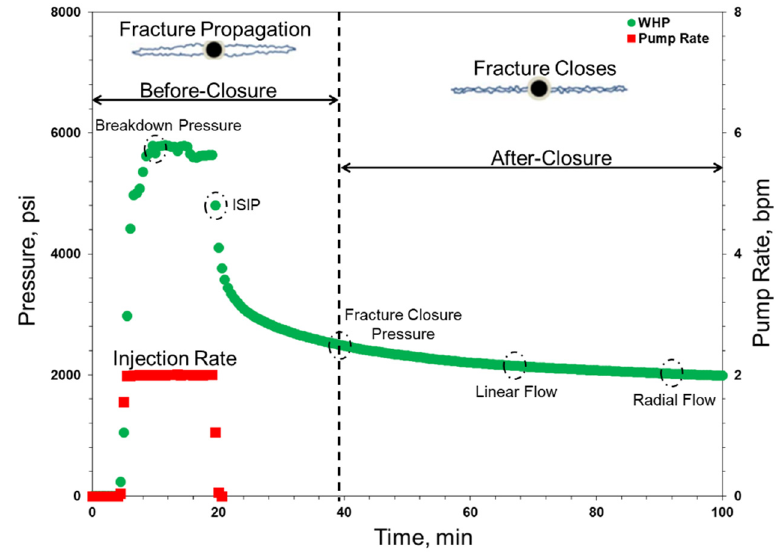
Figure 2. Typical pressure behavior includes a sequence of main events observed in a DFIT. ISIP is instantaneous shut-in pressure.